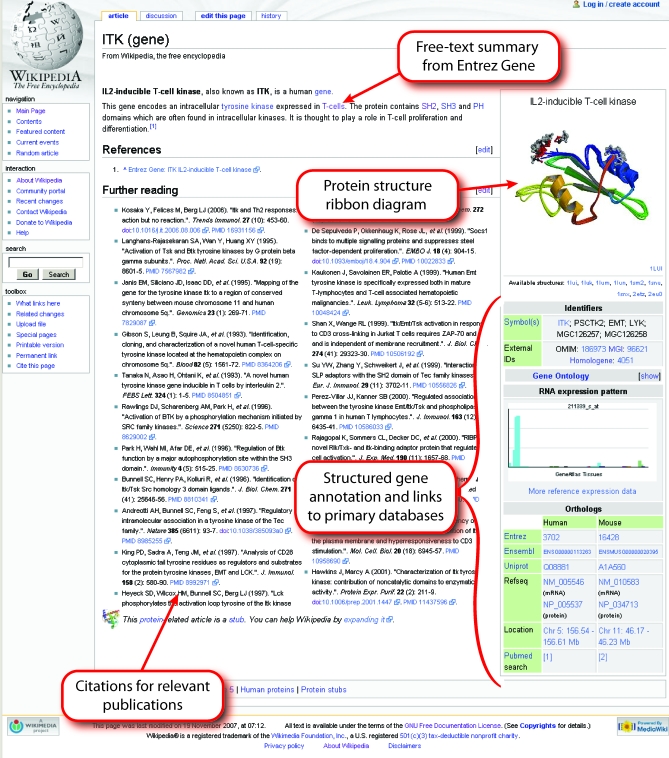
Example Gene Stub Created at Wikipedia for the ITK GeneAll gene stubs include annotation harvested from public databases, including genome location, protein structures, anatomic gene expression patterns, and gene functions.